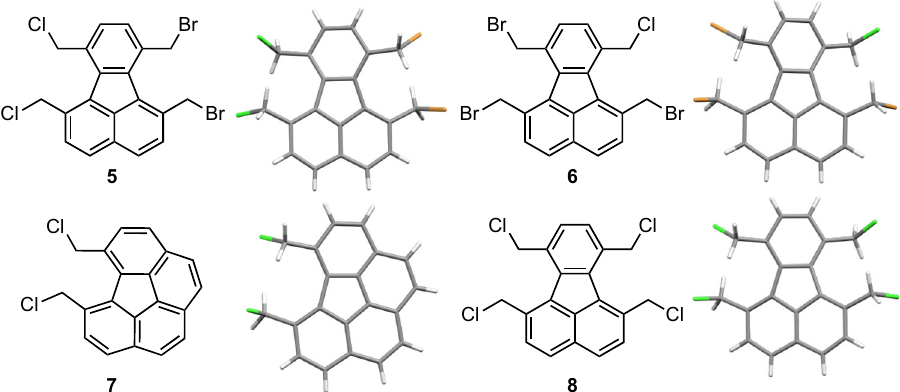
Fig. 5 Chemical and X-ray crystal structures of 5, 6, 7 and 8. The structures for 5 and 6 are found to be disordered at the halogen atoms due to cocrystallization of compounds carrying bromide (shown with a green colour) and chloride (shown with a brown colour) substituents.